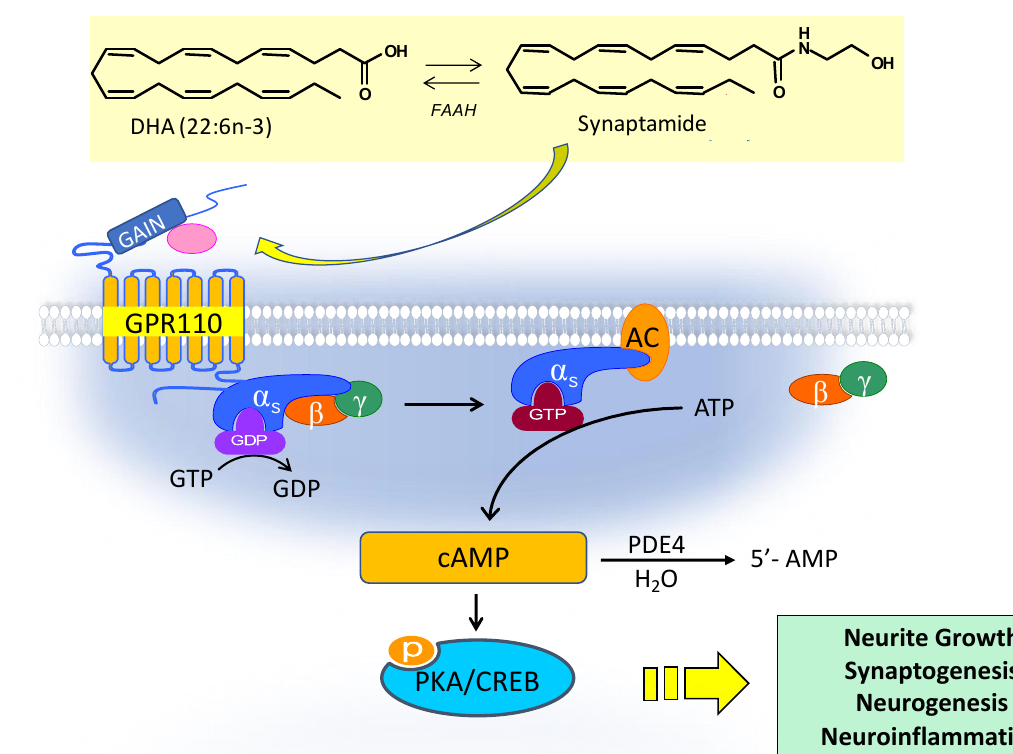
Figure 5. Synaptamide-activated GPR110 signaling. By binding to GPR110, synaptamide activates Gαs protein; increases cAMP; promotes neurogenesis, neurite growth, and synaptogenesis; and inhibits neuroinflammation. DHA, docosahexaenoic acid; FAAH, fatty acid amide hydrolase; GAIN, GPCR autoproteolysis domain; GTP, guanosine-5′-triphosphate; GDP, guanosine-5′-diphosphate; ATP, adenosine-5′-triphosphate; AC, adenylyl cyclase; CREB, cAMP response element-binding protein. Adapted from references [15,49].